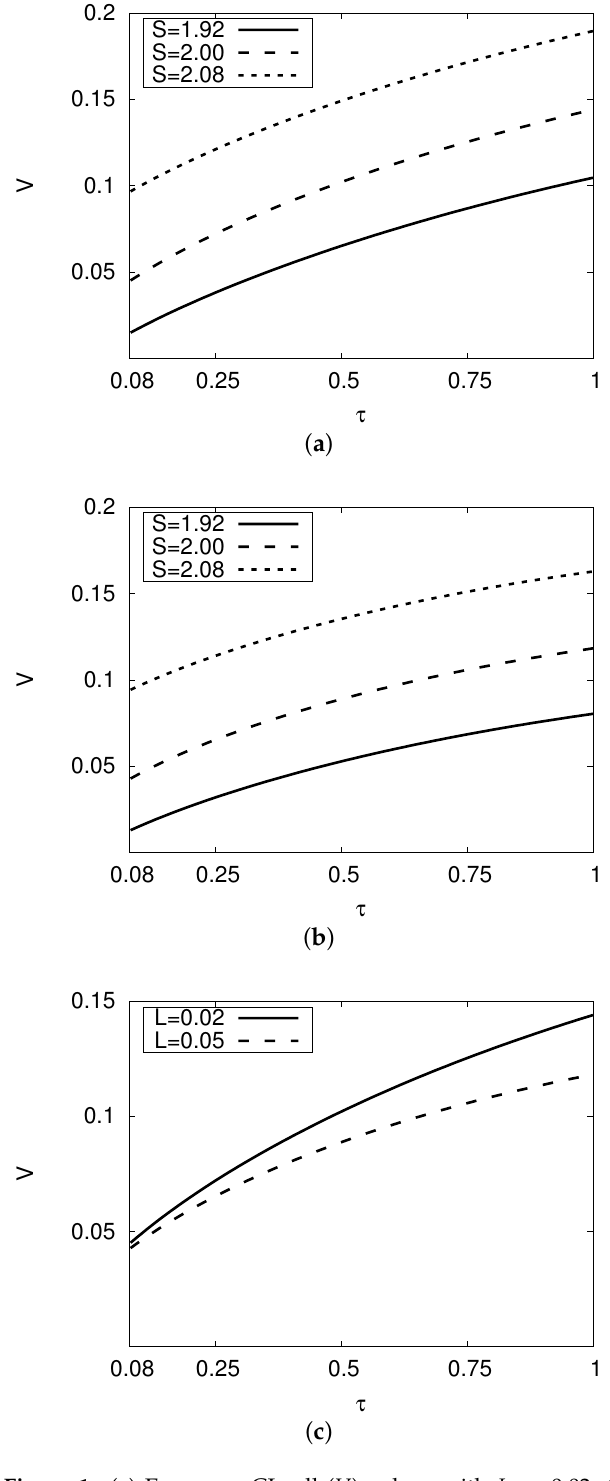
Figure 1. ( a ) European CI call ( V ) values with L = 0.02, ( b ) European CI call ( V ) values with L = 0.05 and ( c ) European CI call ( V ) values with S = 2 for various expiries ( τ ). Parameters used: r = 0.05, q = 0.04, σ = 0.2, X =